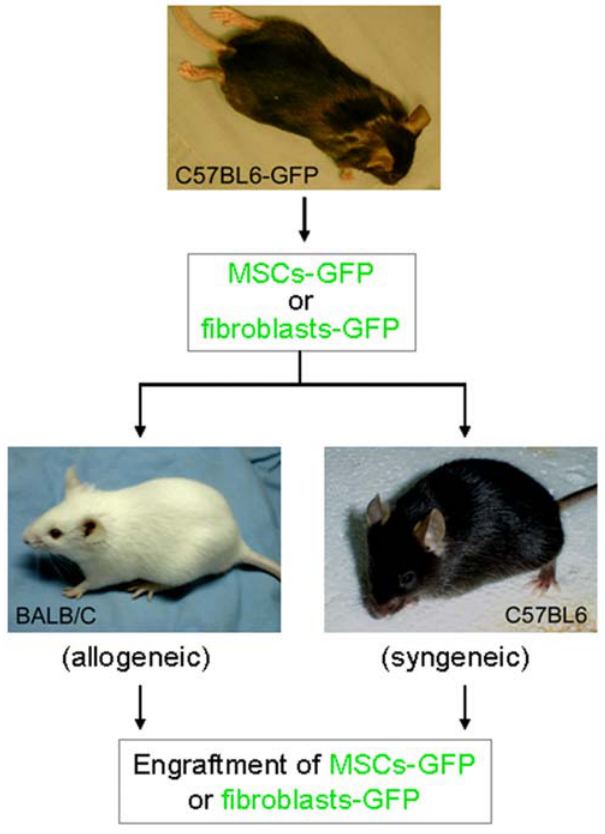
Figure 1. Experimental scheme.